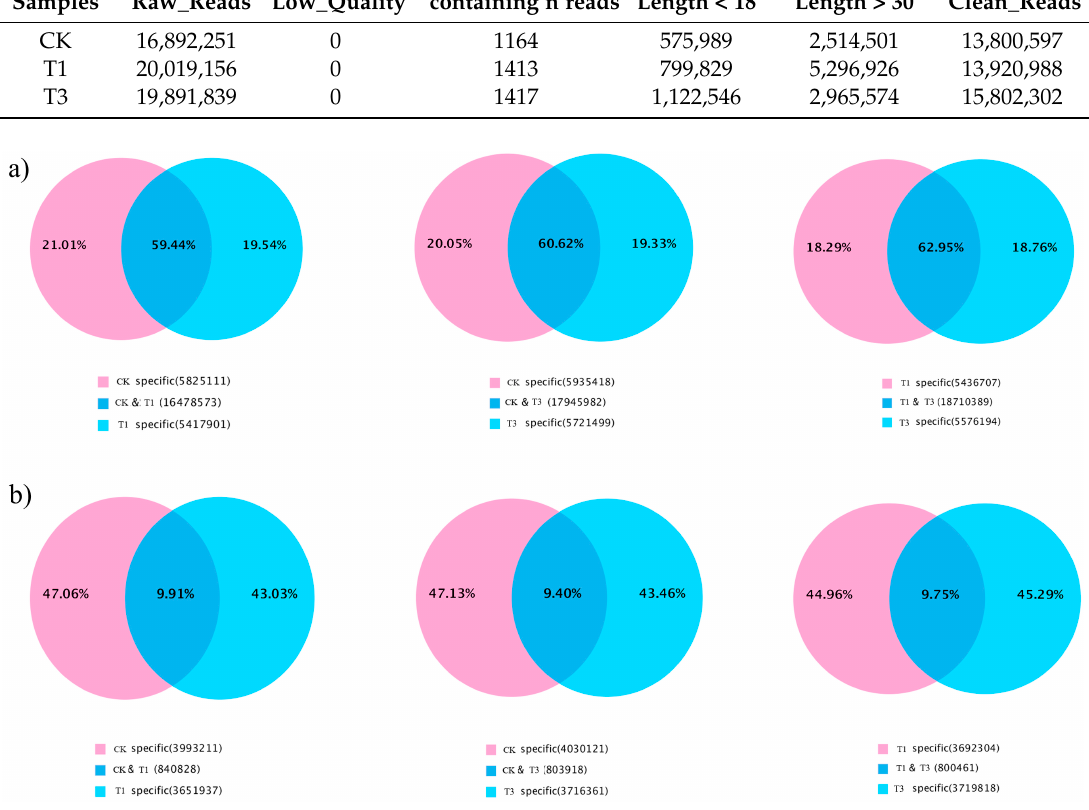
Figure 1. Venn diagrams for analysis of total ( a ) and unique ( b ) reads between each of the two samples of B. napus.